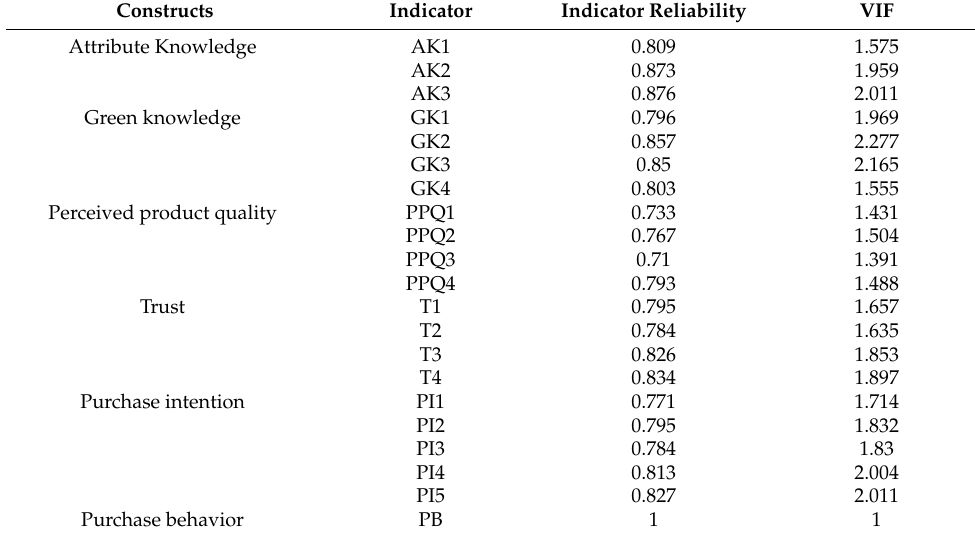
Table 4. Factor loadings and